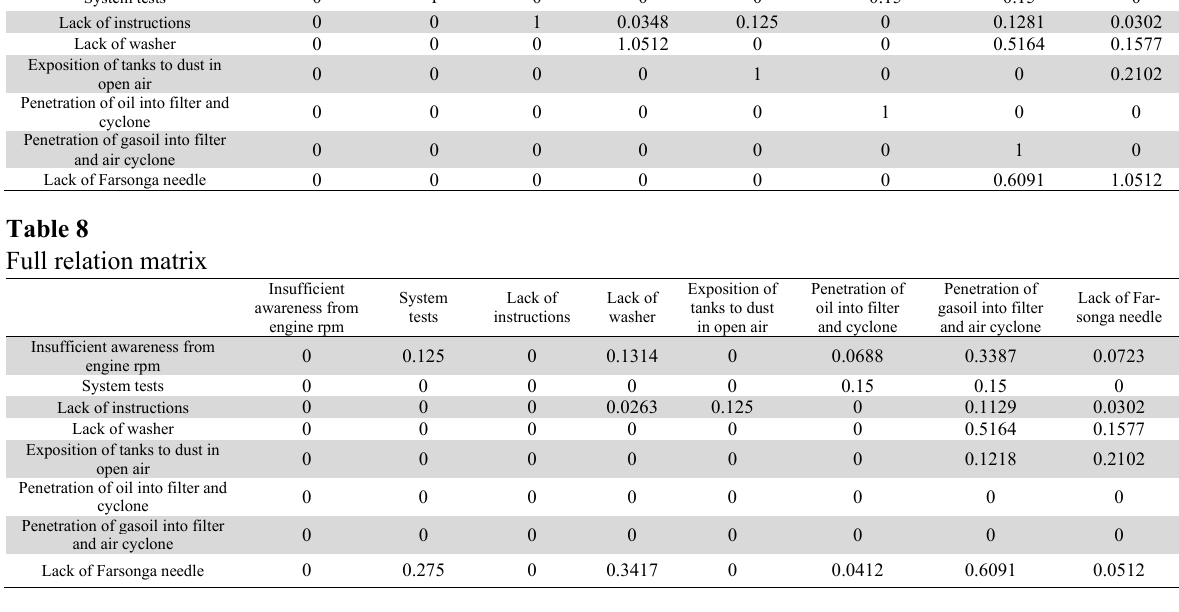
Insufficient awareness from